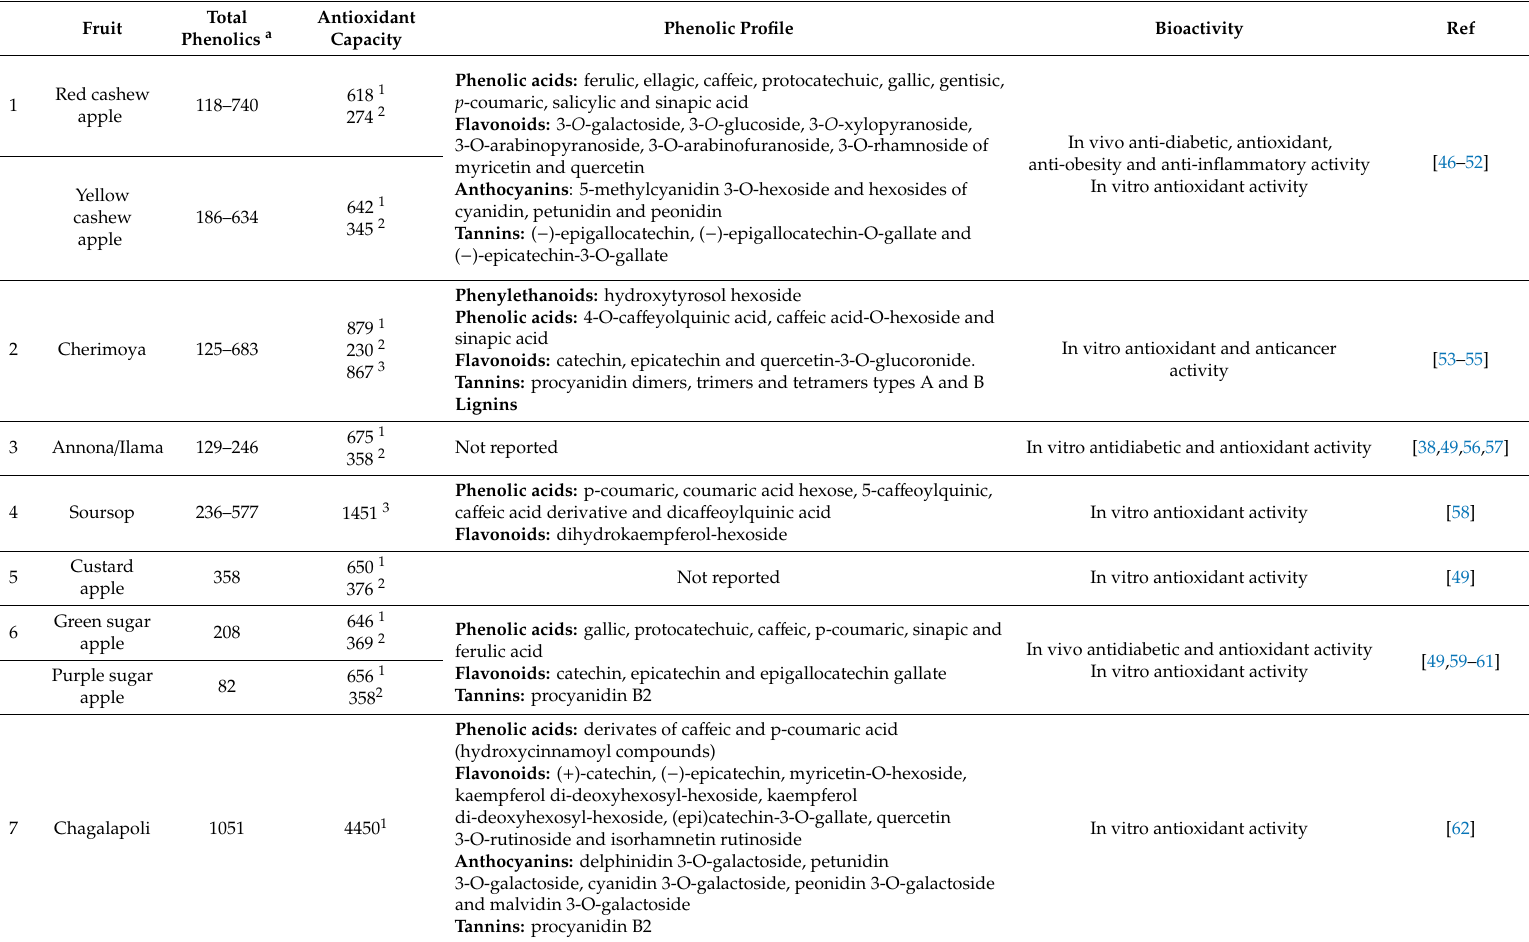
Table 4. Phenolic profile, total phenolic compounds (mg / 100 g fresh weight), antioxidant capacity and in vivo and in vitro bioactivity of Mesoamerican